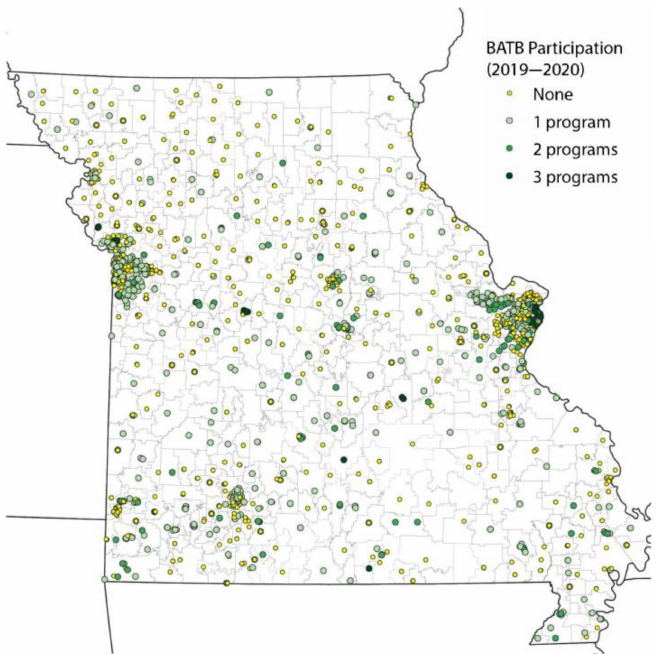
Figure 2. School BATB adoption